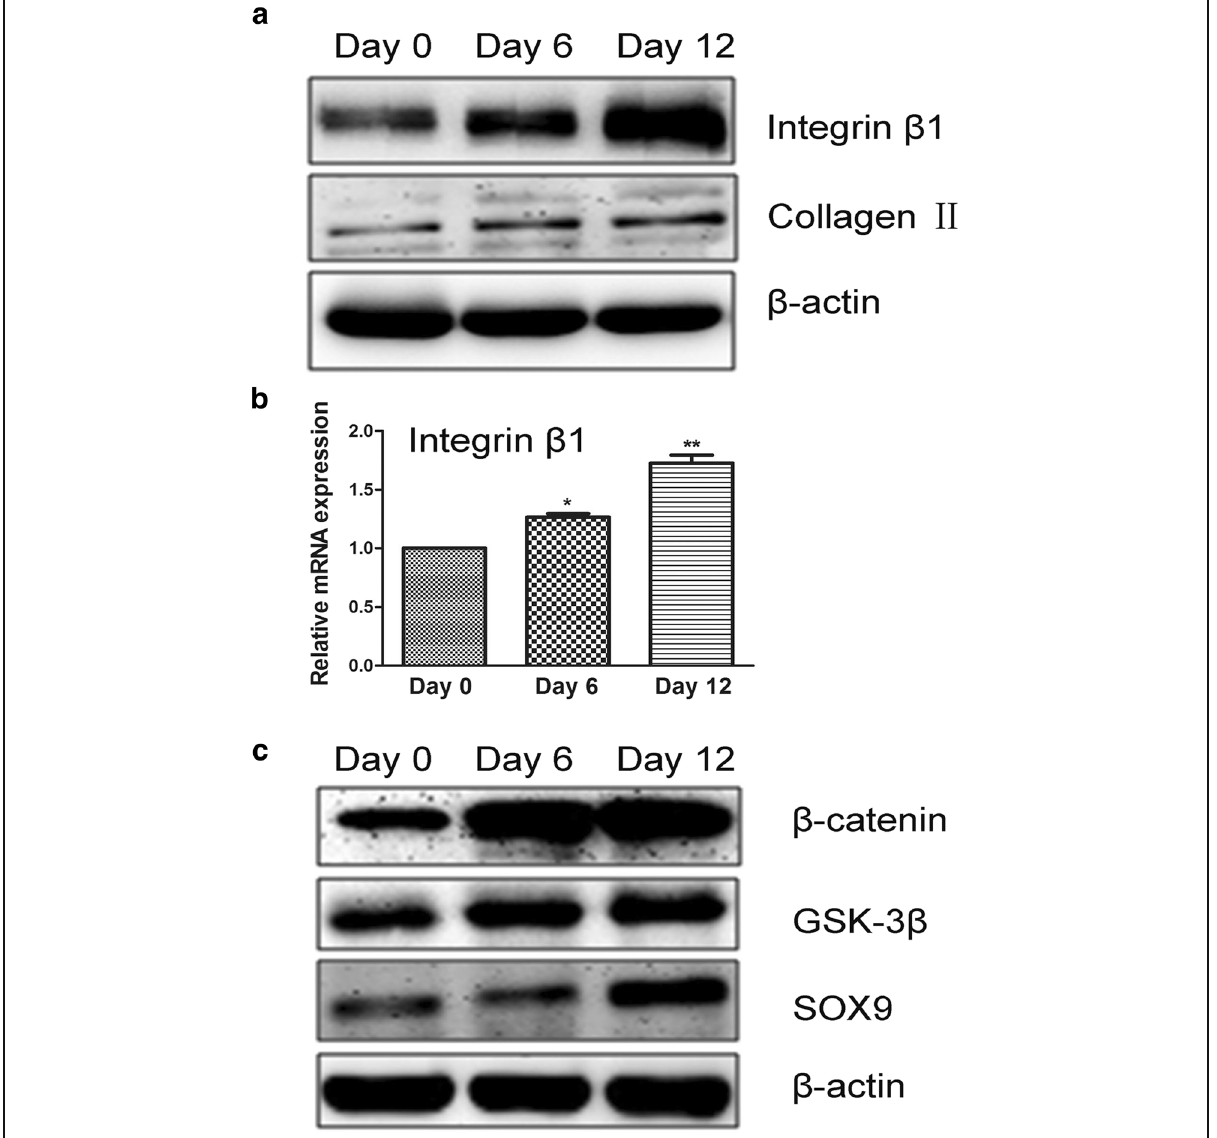
Fig. 6 The role of integrin β 1 and β -catenin/SOX pathway in regulating hADSc chondrogenic differentiation. a Protein integrin β 1 was up-regulated during chondrogenesis of hADSc as assessed by western blotting. Cartilage differentiation up-regulated collagen II expression at different days. b The mRNA of integrin β 1 was up-regulated during chondrogenic differentiation of hADSc. c Measurement of proteins associated with the β -catenin/SOX pathway during chondrogenic differentiation of hADSc for 0, 6, and 12 days. * p <0.05, ** p